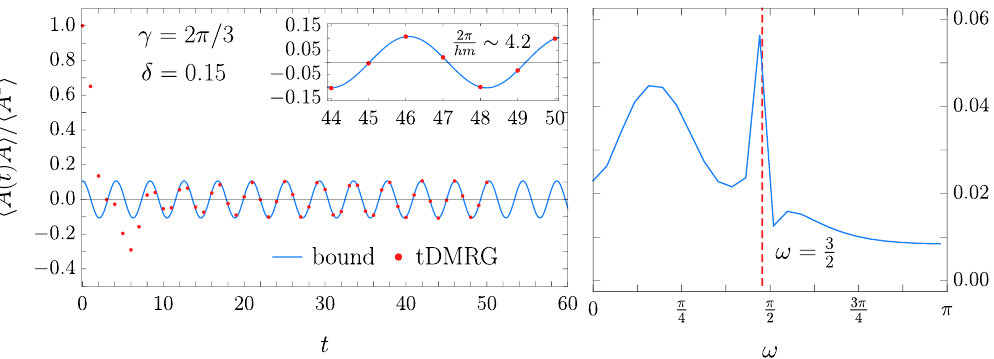
Figure 3: In the left figure we plot numerical tDMRG data (red dots) and analytical result (blue line) for the Fourier component of the dynamical susceptibility. Param- eters are γ = 2 π/ 3 and δ = 0.15. Strength of the magnetic field is h = 1 / 2 and the frequency of oscillations is hm = 3 / 2. The period of oscillation is clearly discernible in the inset. In the figure on the right, we plot the power spectrum obtained from the tDMRG data on the left, and denote the expected frequency of oscillations by a red dotted